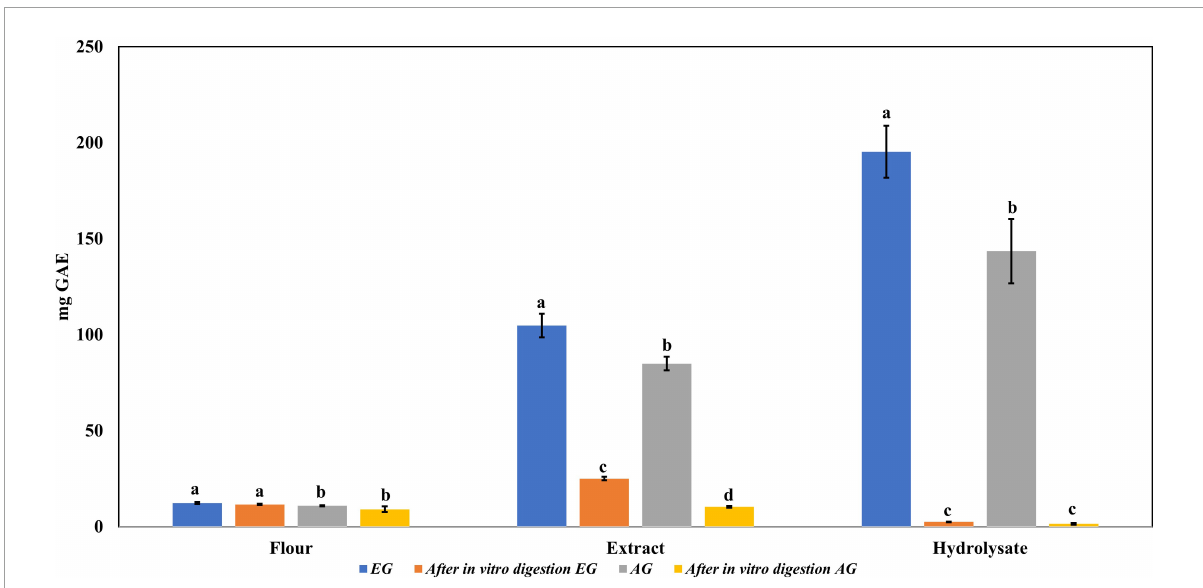
FIGURE5 Total phenolic content in flour, extracts, and hydrolysates of early grasshopper (EG) and adult grasshopper (AG) before and after in vitro protein digestion. Results obtained are reported in milligrams of gallic acid equivalents (mg GAE)/gram dry weight. Different letters between bars indicate significant difference ( p -value < 0.05).